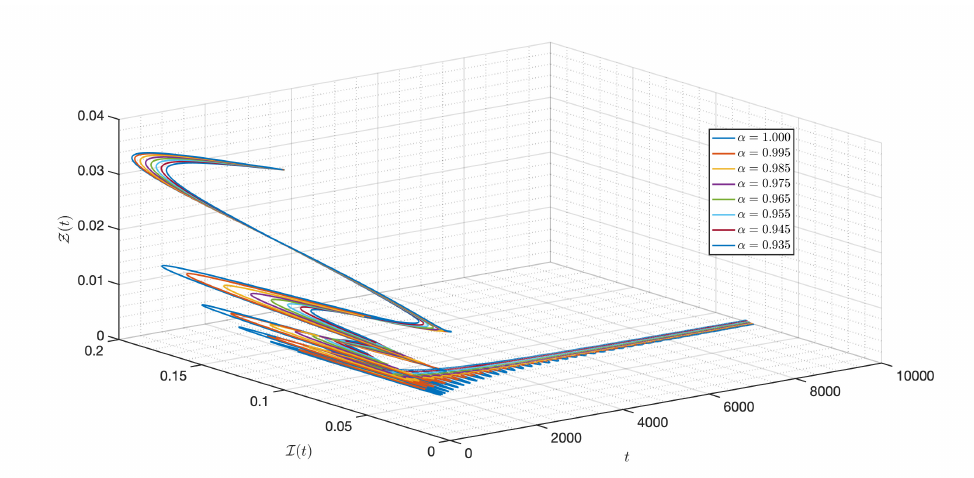
Figure 10. Dynamic of the model (3) for different parameters in Case I .